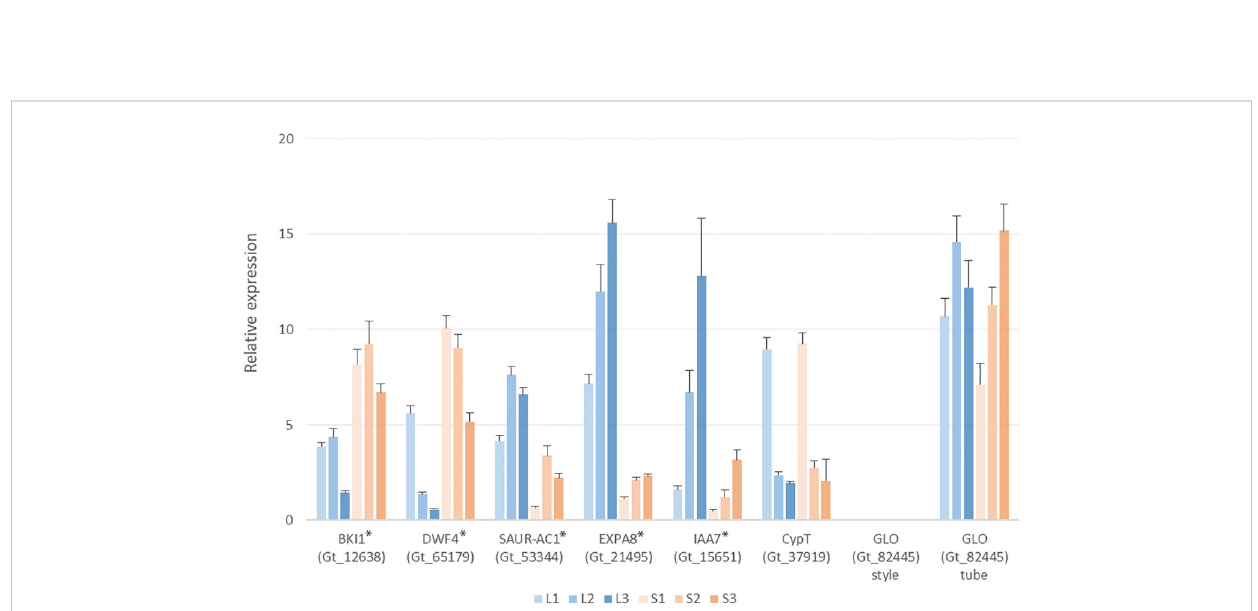
FIGURE 7 Q-PCR analysis showing expression levels of selected genes in the L- and S-morph styles of Guettarda speciosa. Error bars indicate the S.E. of three biological repeats. L1 (S1), L2 (S2) and L3 (S3) represents the three developmental stages, respectively. The tested genes showed signi fi cant differential expression between L- and S-morph (indicated by *), except CypT and GLO .